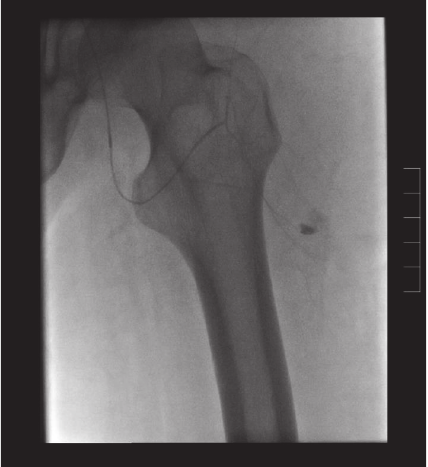
Figure 4: Selective catheterization confirmed the supply to the bleeding